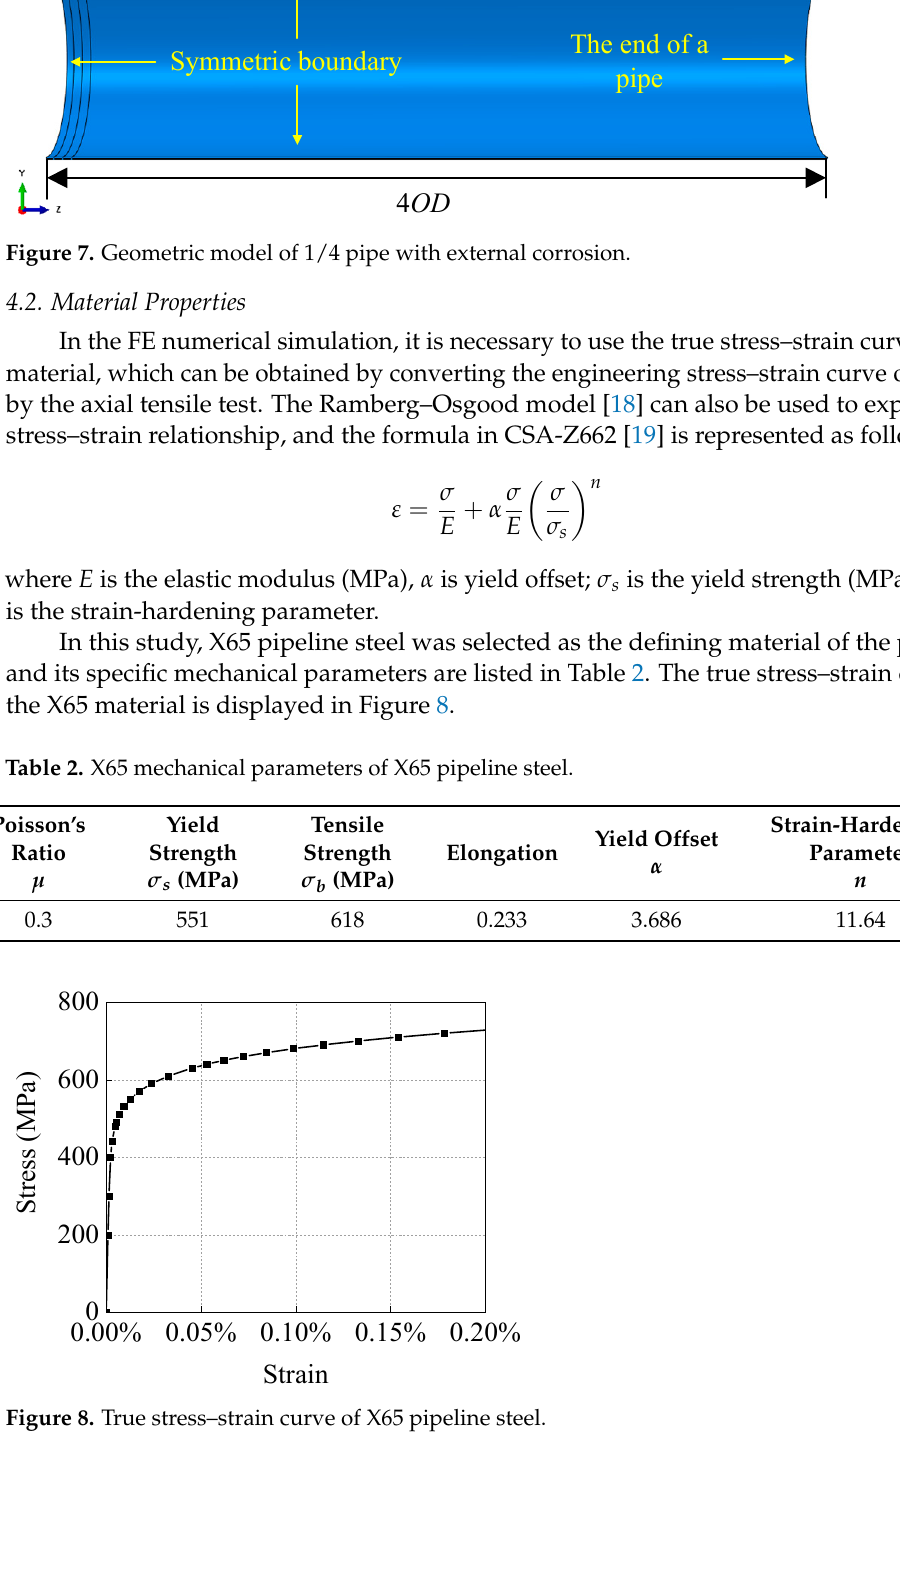
D t d Figure 9. Schematic diagram of external corrosion defect. Figure 10. Corrosion interior edge chamfer.